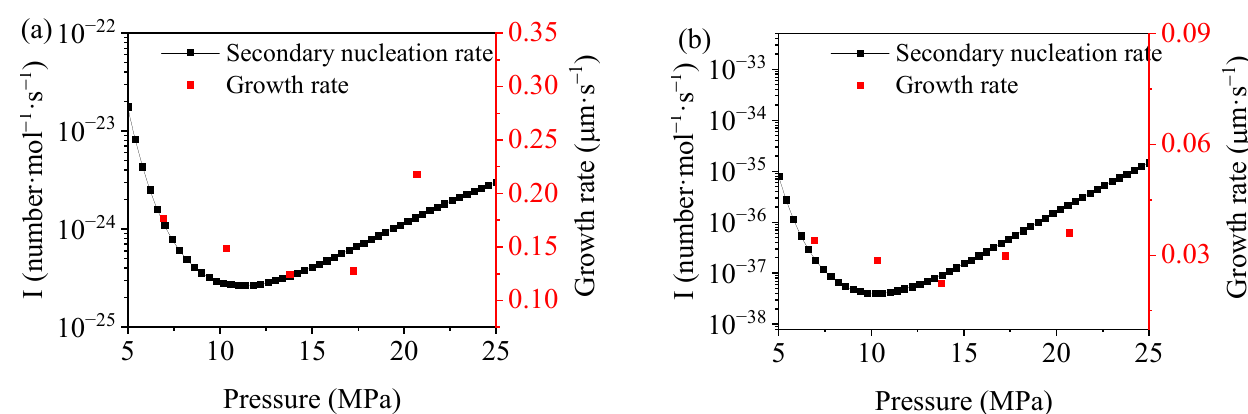
Figure 7. Growth rate calculated by experiments and secondary nucleation rate calculated by model for PP/GN nanocomposite under different temperature, ( a ) 130 °C and ( b ) 140 °C. In order to elucidate the re-promoting effect of supercritical N 2 on the grain growth rate, Figure 8 shows the variation of each free energy with pressure. The percentage of each free energy at a given pressure is given in Table 1. After the addition of GN, it is still the ∆ E and ∆ G ∆ G N that have a large effect on the secondary nucleation rate. f , the percentage of free energy caused by GN accounts for only 0.03%, which is due to the relatively small amount of GN added. It is important to note that the positive value of ∆ G f is a resistance to secondary nucleation, which will limit the grain growth rate. This is mainly due to the influence of the interfacial energy existing between GN and PP. For the PP molecular chain to detach itself from the PP/GN/N 2 three-phase system to nucleate, it needs to conquer not only the influence of N 2 , but also the interfacial energy between PP and GN. Table 1. Detailed percentage of ∆ G N , ∆ G f , ∆ E , ∆ G ∗ under different pressures. Temperature ( ◦ C) Pressure (MPa) ∆ G * ∆ G N ∆